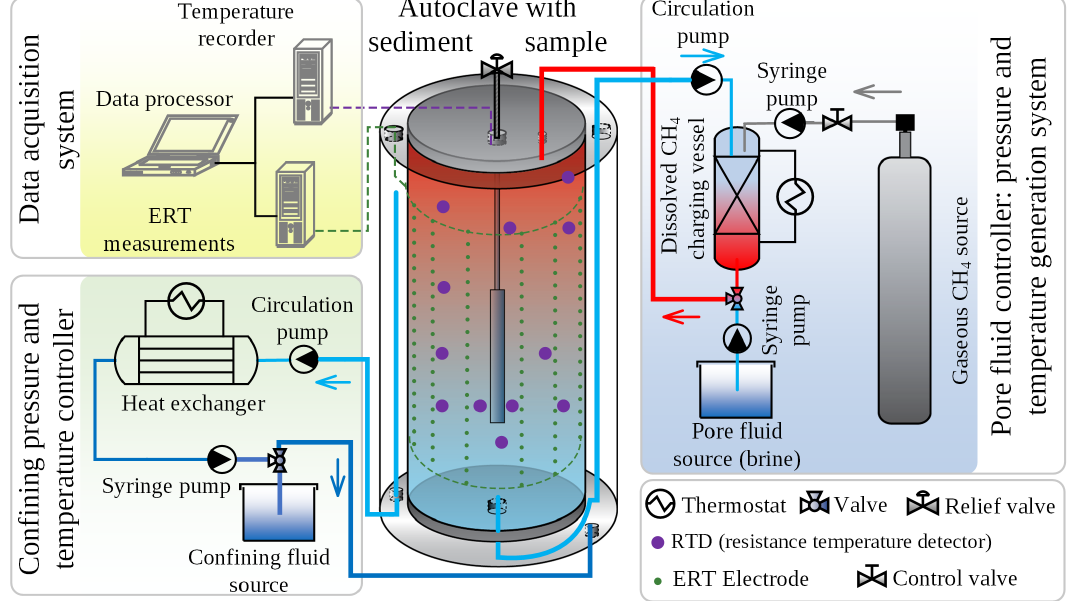
Figure 1. Schematic of LARS setup used in the CH 4 hydrate formation study (not to scale), modified from